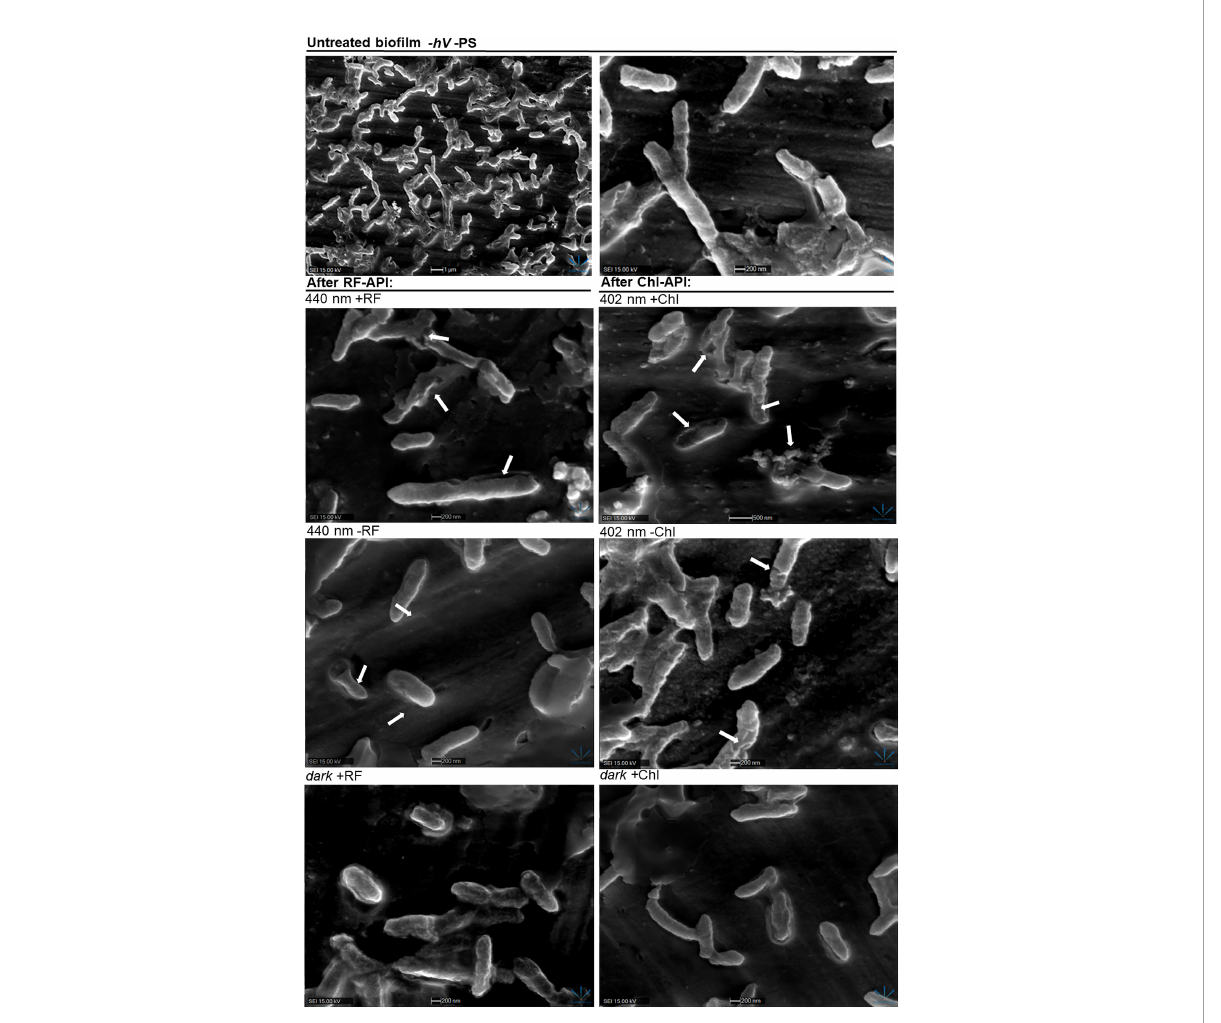
FIGURE 8 SEM images of Brevundimonas sp. ESA1 bio fi lm cells: untreated (-hV – PS: no PSs (RF nor Chl) in dark conditions); after RF-API : 440 nm +RF (treated with 0.011 mM RF and irradiated by 440 nm up to 140 J/cm 2 ), 440 nm -RF (not treated with 0.011 mM RF prior to irradiation, cells were covered with 0.1 M phosphate buffer (pH 7.4) and irradiated by 440 nm up to 140 J/cm 2 ), dark +RF (bio fi lms treated with 0.011 mM RF and incubated in the dark for an amount of time corresponding to time needed to achieve 140 J/cm 2 ); after Chl-API : 402 nm +Chl (treated with 0,015 mM Chl and irradiated by 402 nm up to 70 J/cm 2 ), 402 nm -Chl (not treated with 0,015 mM Chl prior to irradiation, cells were covered with 0.1 M phosphate buffer (pH 7.4) and irradiated by 402 nm up to 70 J/cm 2 ), dark +Chl (bio fi lms treated with 0,015 mM M Chl and incubated in the dark for an amount of time corresponding to time needed to achieve 70 J/cm 2